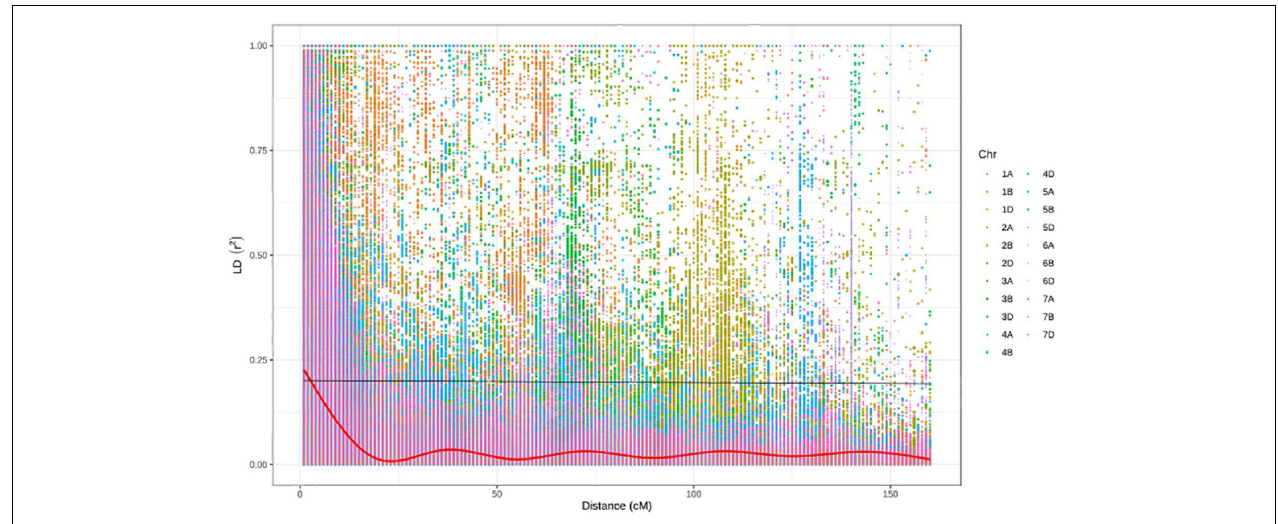
FIGURE 4 | Decline of LD as measured by R 2 against genetic distance